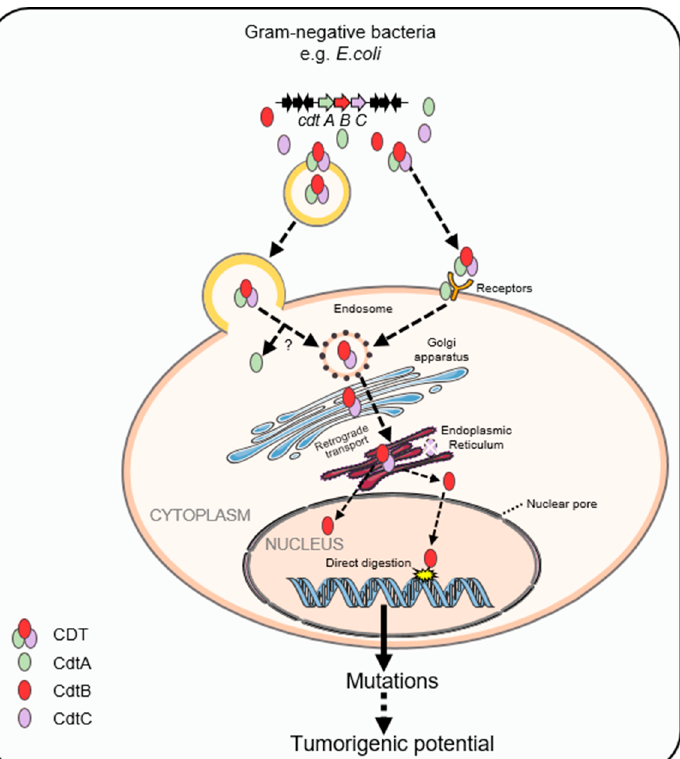
Figure 1. The PDB structure of the CDT toxin from Actinobacillus actinomycetemcomitans . The yellow color indicates the CdtA subunit, the pink color is for the CdtB subunit, and the blue color codes for the CdtC subunit. CdtA and CdtC together form a deep grove.